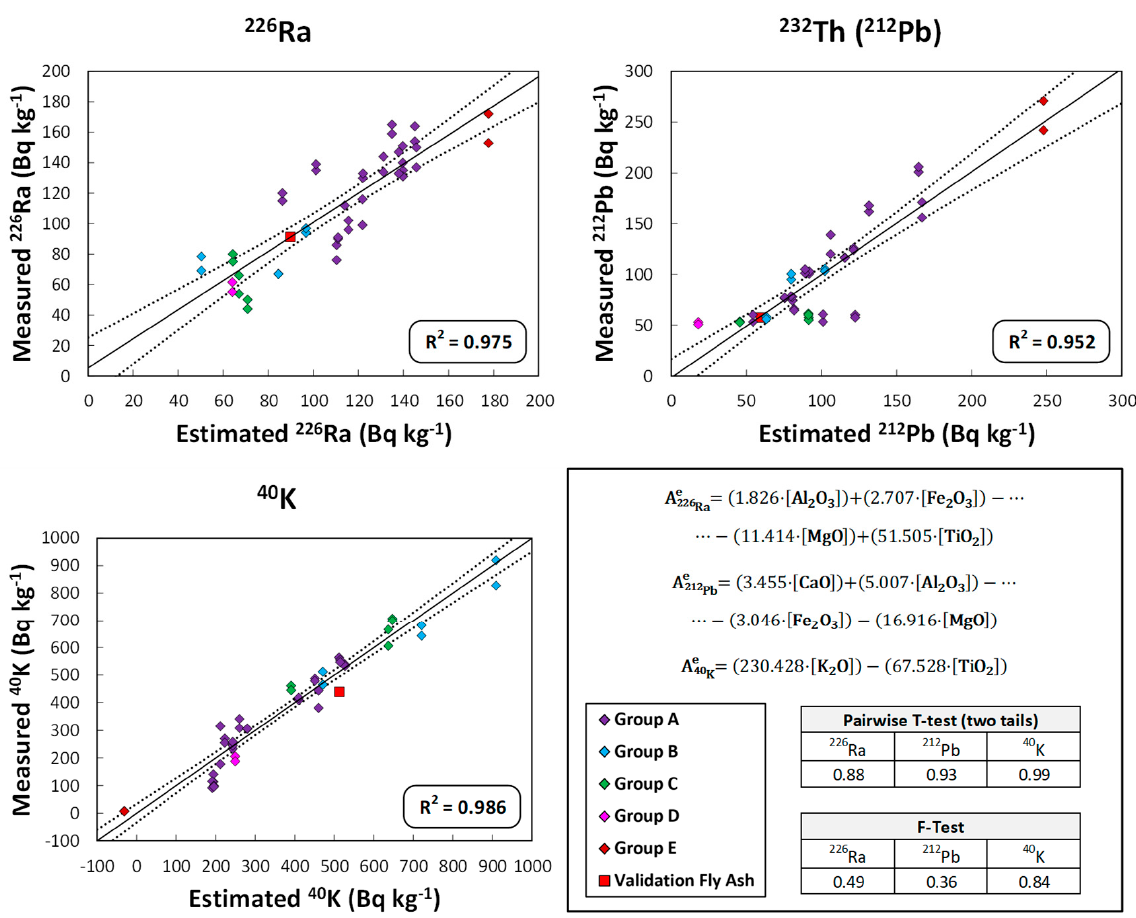
Figure 7. Graphical representation of the experimentally measured 226 Ra, 232 Th( 212 Pb), and 40 K activity concentration values versus those estimated by the obtained models relating the chemical composition of the ashes to the activity concentration of the different radionuclides. The models explain more than 95% of the dispersion. The clusters represented by the confidence ellipses in the HJ-Biplot in Figure 4 are shown in the same color as the plotted points. The comparison between experimental and estimated values showed no significant differences, as the p -values for the paired t -test and Fisher’s F-test were higher than the α significance value of 0.05. The results obtained in the validation of the method are included to check their agreement with the proposed model.